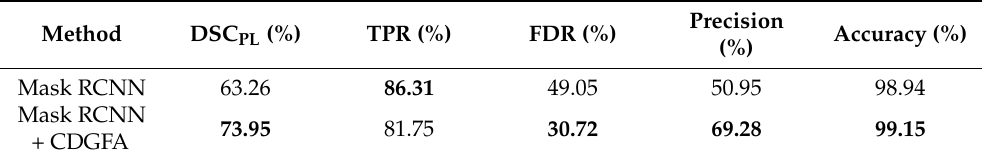
Table 5. The average of the performance parameters of the Mask RCNN and Mask RCNN + CDGFA extraction results when the block size of the test dataset is 960 × 540.